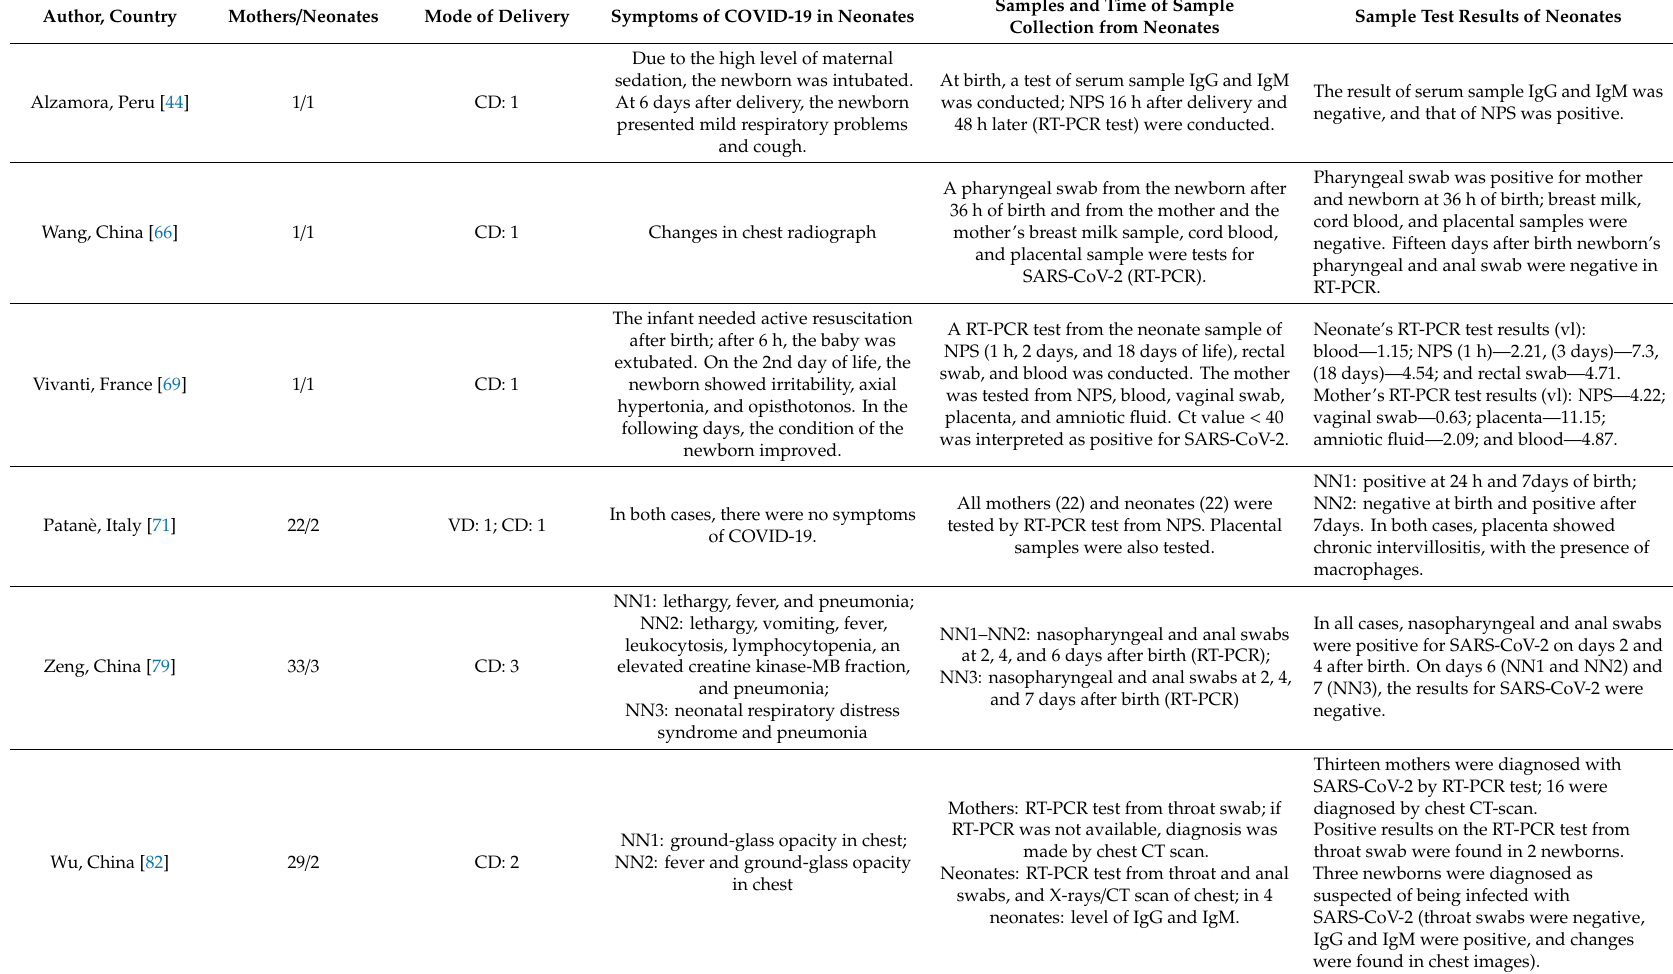
Table 2. Characteristics of studies showing intrauterine transmission from mother to